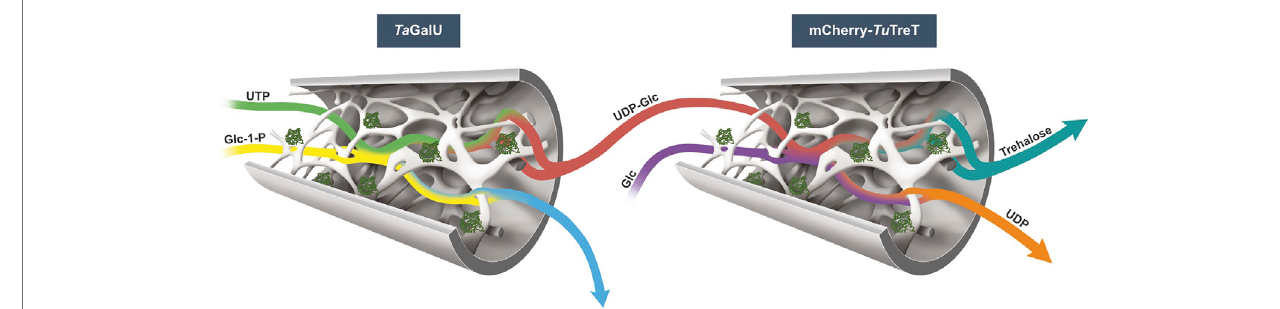
FIGURE 4 | Trehalose synthesis by Ta GalU and mCherry- Tu TreT cascade.